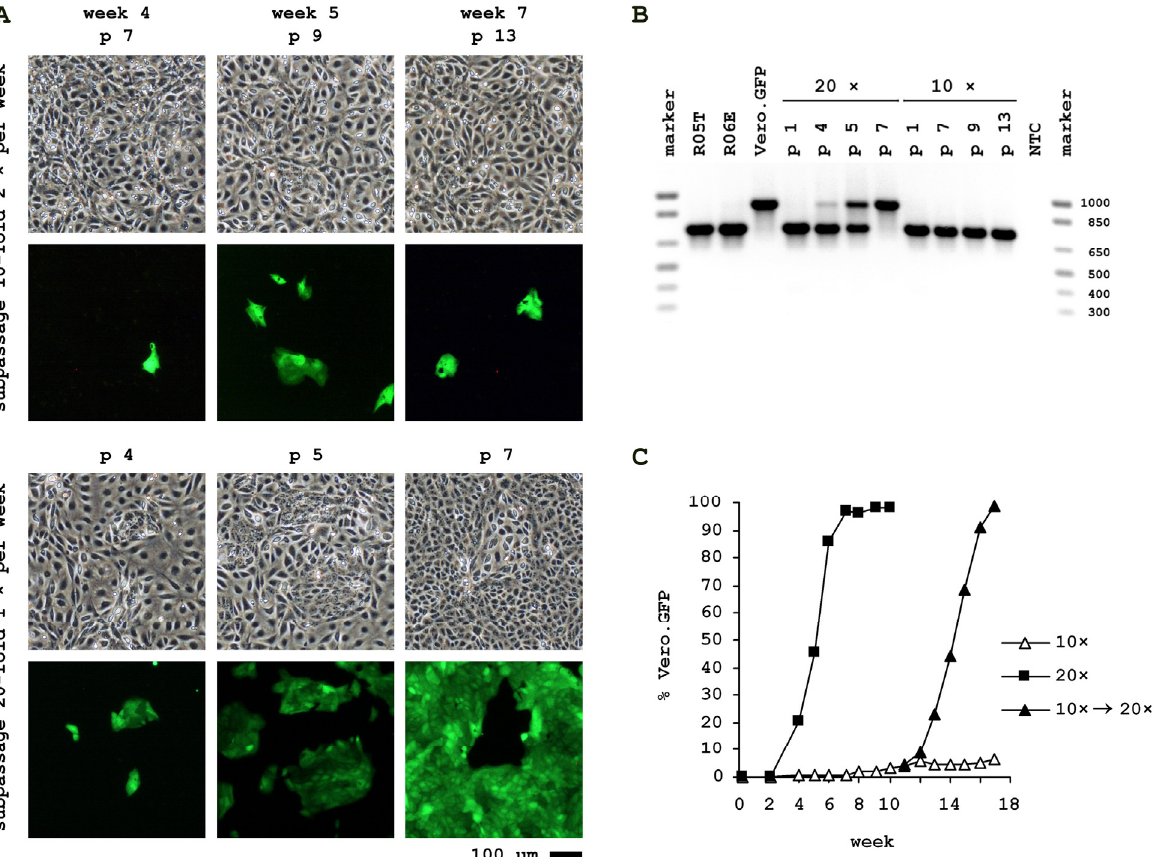
Figure 3. Cocultivation of Vero.GFP with R06E. The cocultures shown differ only by frequency of splitting. ( A ) Bright field and fluorescence pictures were taken at different passages after spiking of Vero cells, stably expressing GFP, into R06E cell culture; ( B ) Species-specific MACF1 PCR of fruit bat (R05T, R06E), monkey (Vero.GFP) and spiked cell cultures with different splitting procedures (as shown in A) at various passage levels; ( C ) Ratio of GFP-positive Vero to R06E in different cell cultures. Cells were quantified by FACS